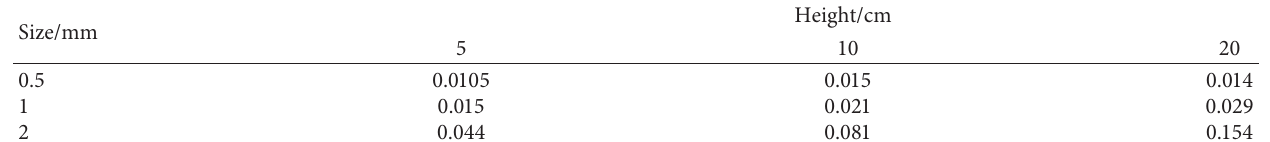
Table 4: The corresponding k value of each group of experiments.